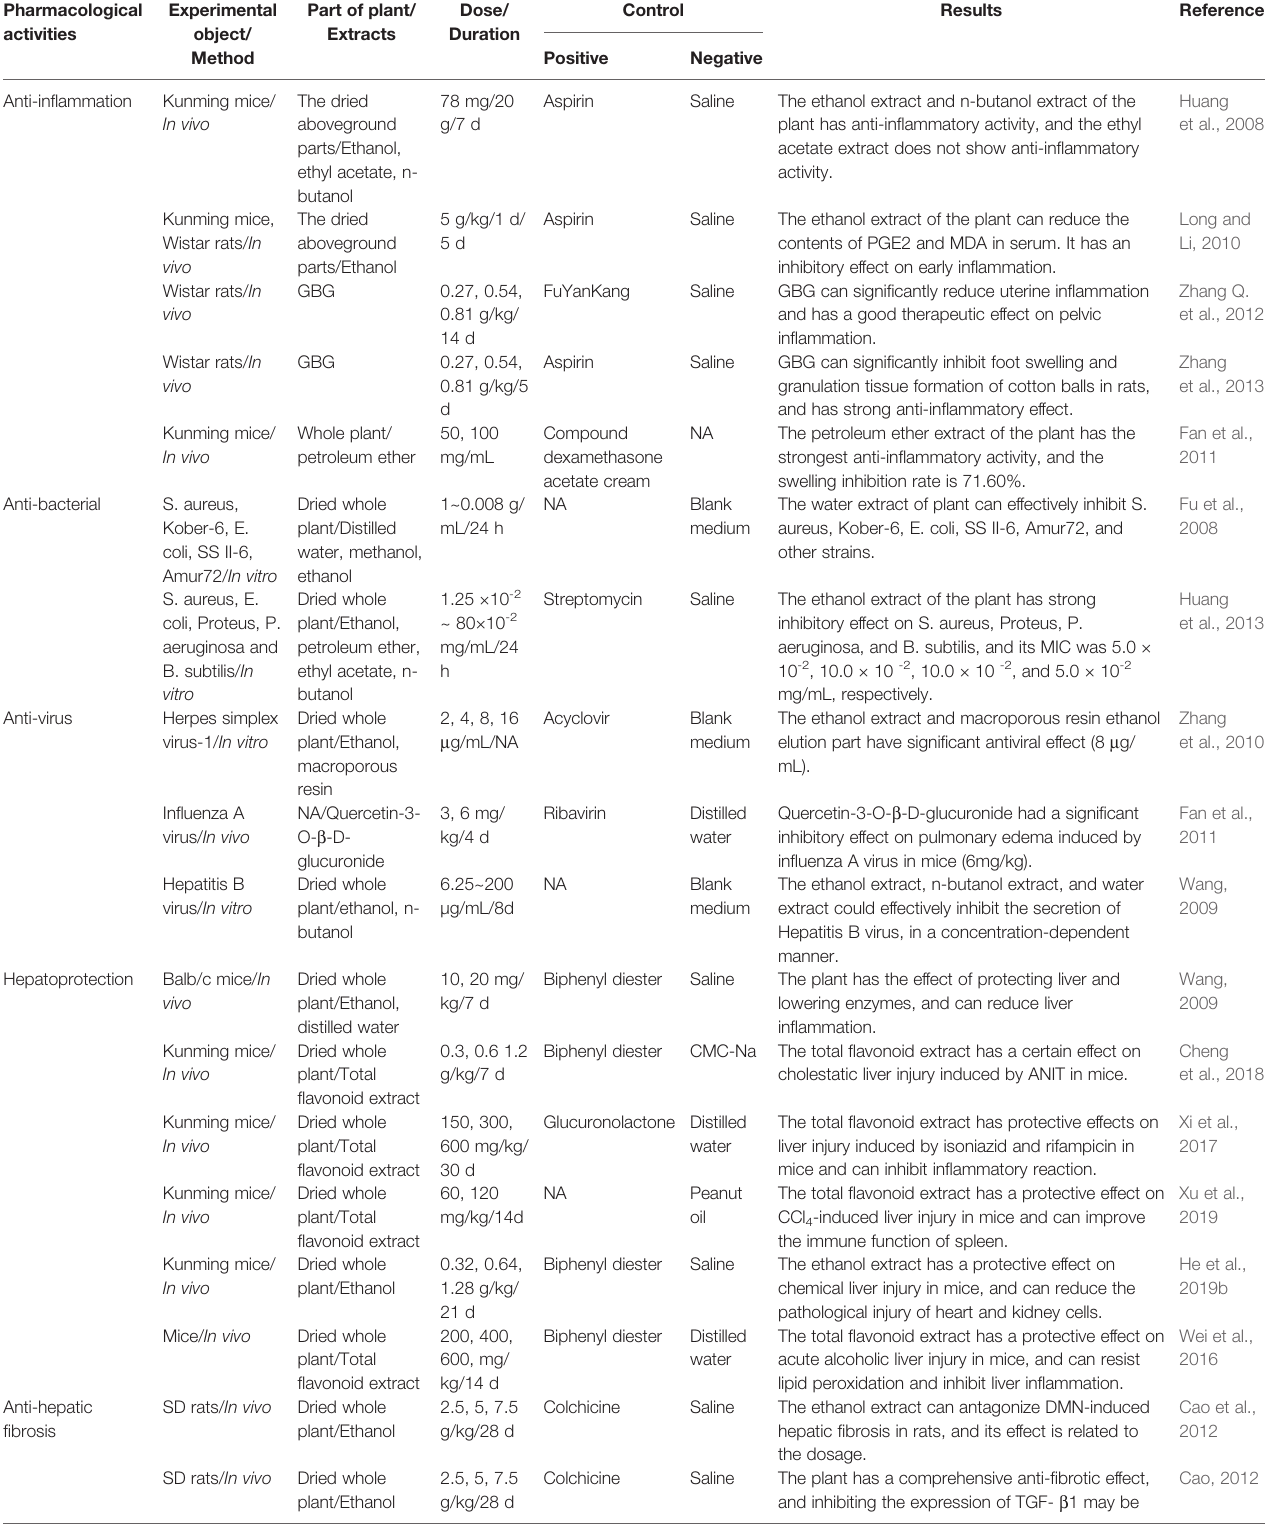
TABLE 2 | Pharmacological activities of P. perfoliatum